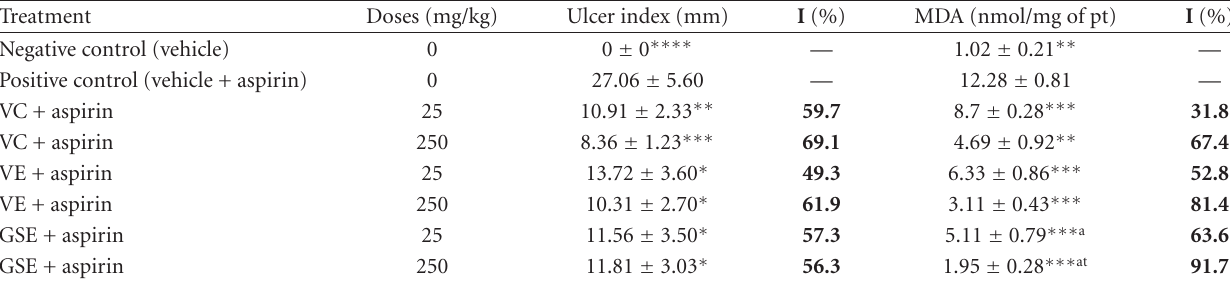
Table 1: E ff ects of GSE, VC, and VE on ulcer indexes and MDA gastric concentrations in rats with aspirin-induced ulcer. Treatment